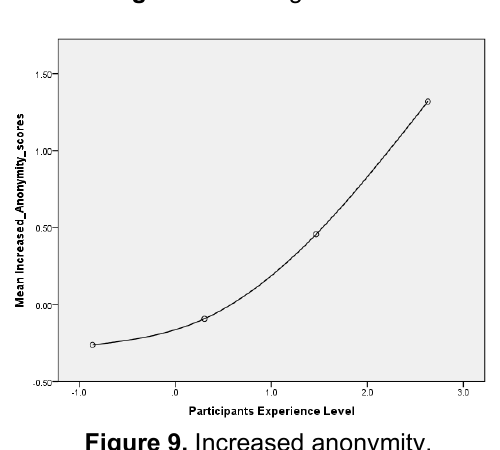
Figure 9. Increased anonymity.